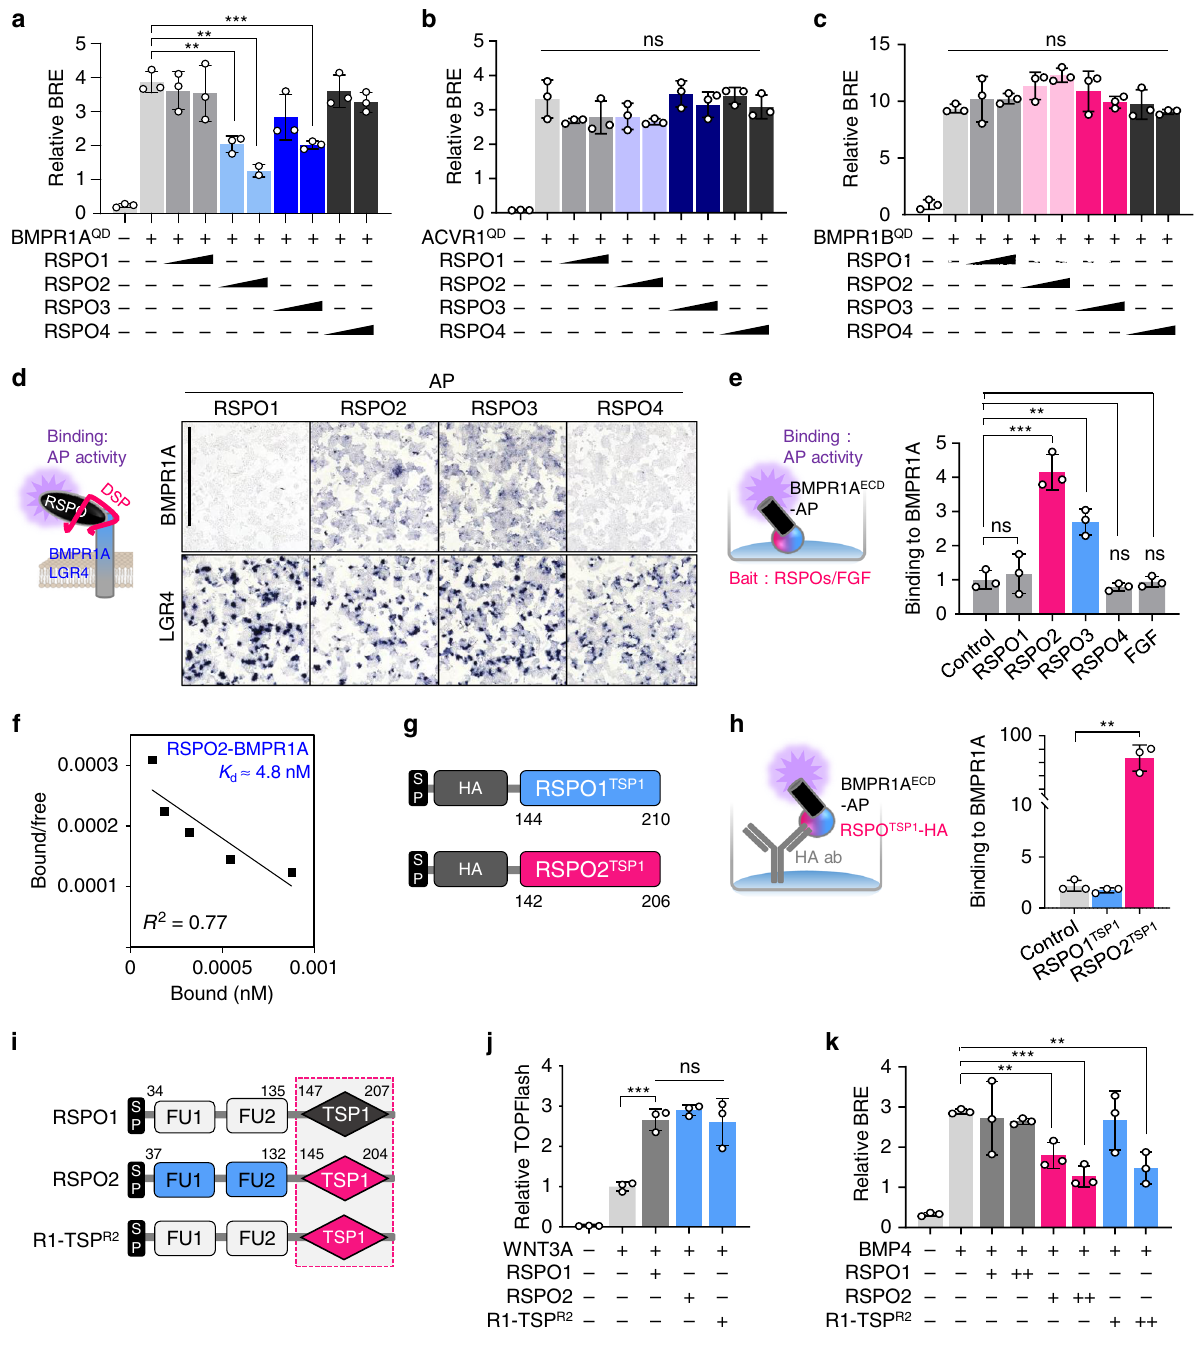
RSPO2 acts via ZNRF3/RNF43 E3 ligases to interfere with BMPR1A. ZNRF3 and RNF43 were both expressed in HEPG2 and H1581 cells, and could be signi fi cantly knocked down by siRNA (Supplementary Fig. 7a). Knockdown of Z NRF3 / RNF43 (Fig. 7a) or expression of a dominant negative ZNRF3 (ZNRF3 Δ R ) 26 (Fig. 7b) prevented inhibition of BMP signaling by RSPO2 in HEPG2 cells, supporting that RSPO2 requires ZNRF3/ RNF43 to antagonize BMP signaling. In Xenopus , znrf3 was broadly expressed from gastrula stages onwards, like bmpr1a (Supplementary Fig. 7b, c). znrf3 ablation by Mo elicited head and axis defects that were rescued by coinjection of human ZNRF3 mRNA, as previously described 43 (Supplementary Fig. 7d,